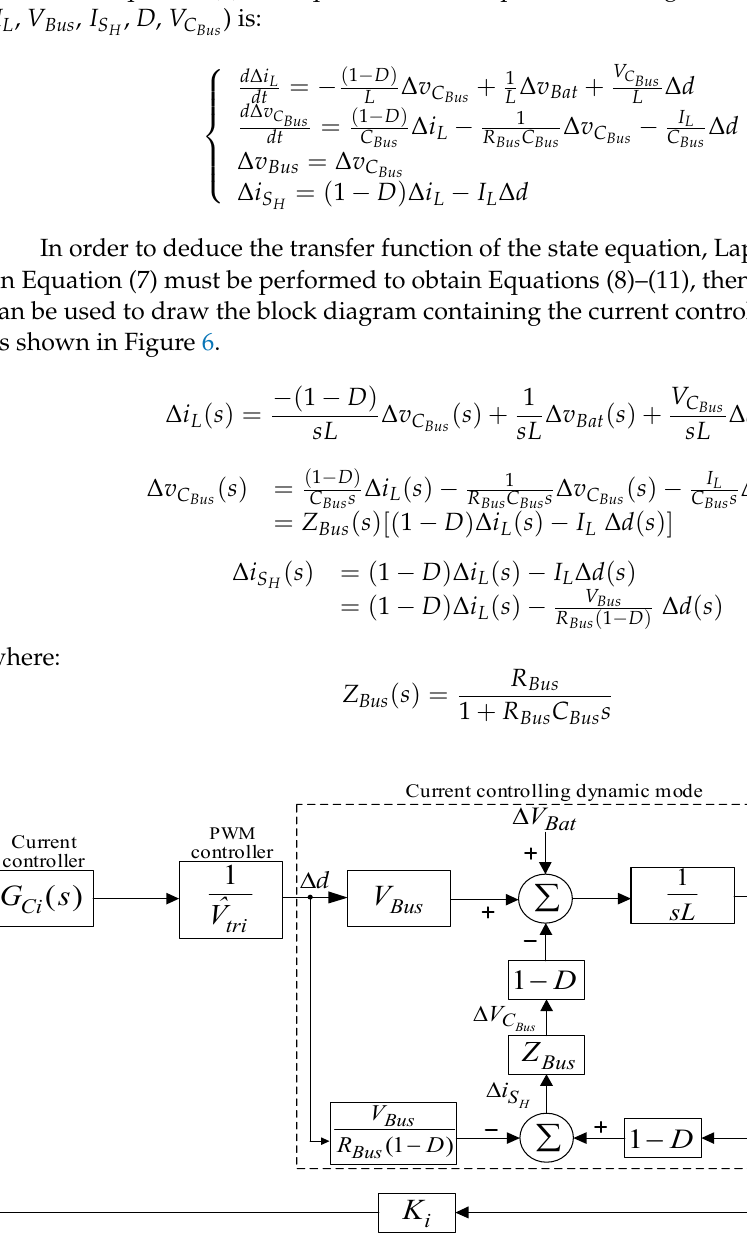
Figure 6. Block diagram of control system for input current of the bidirectional soft-switching converter.